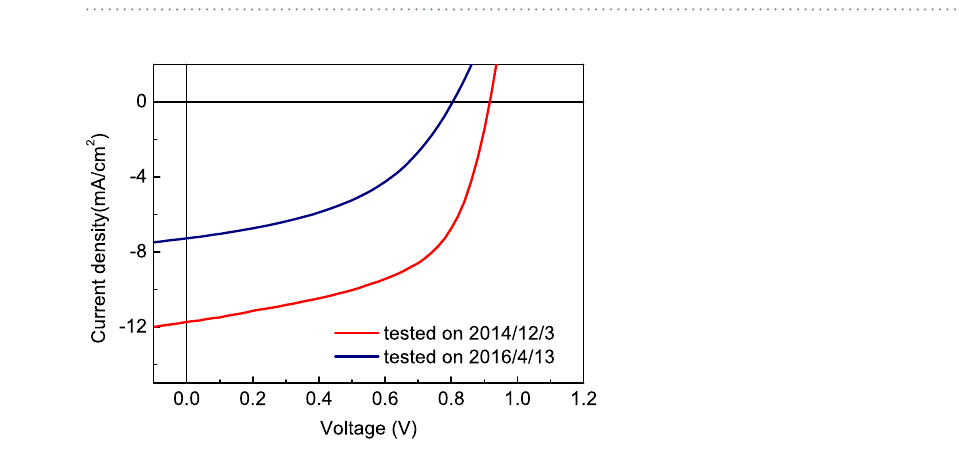
Figure 1. ( a ) Molecular structure of PFDT2BT-8 and PC 71 BM, ( b ) Schematic of device structure and ( c ) Image of a typical OPV device.